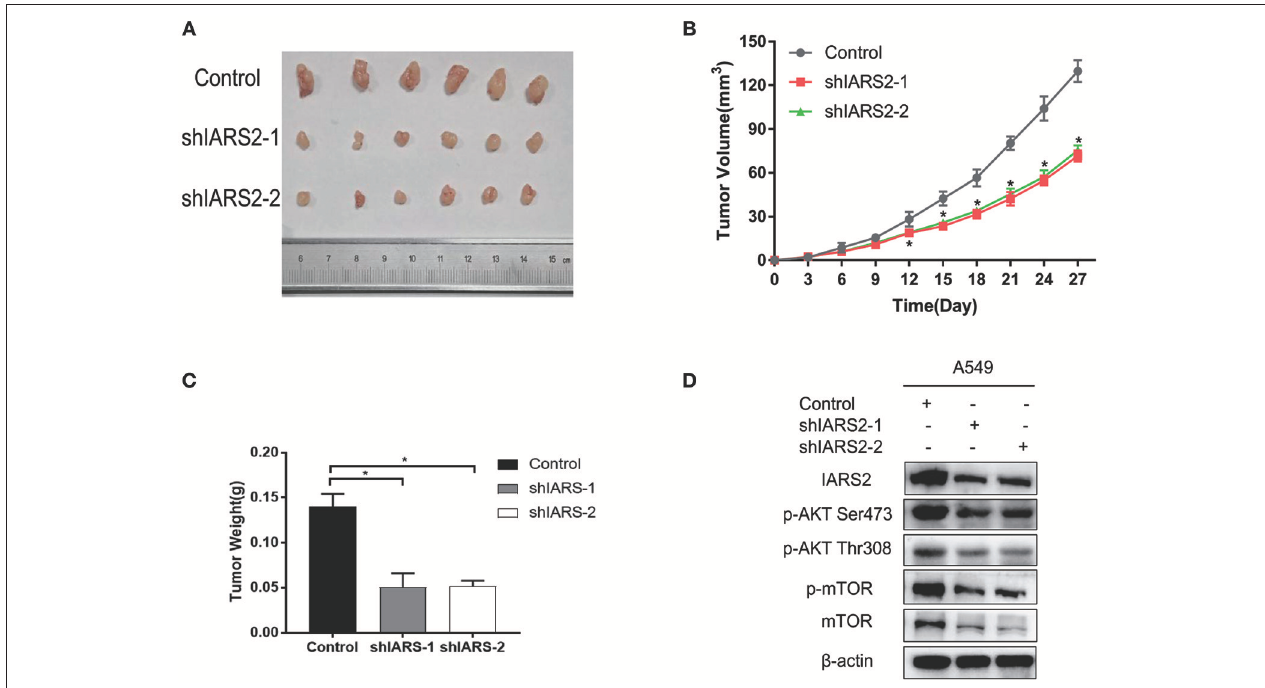
FIGURE 7 | IARS2 silencing inhibits tumor growth in vivo . (A) Xenografts from mice in each group. (B) Tumor volumes were measured at the indicated times. (C) Mean weights of tumors obtained from mice. * p < 0.05 compared with the control group. (D) Western blotting analyses of protein expression in tumour